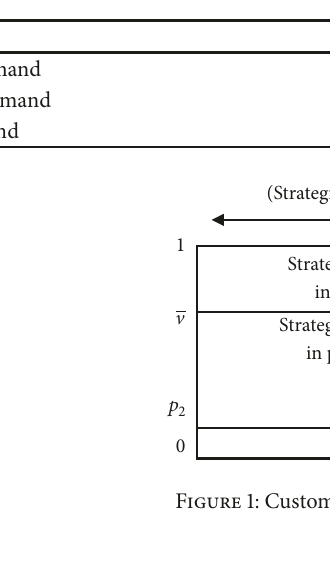
Table 1: Demand (sales) to each consumer segment by period.